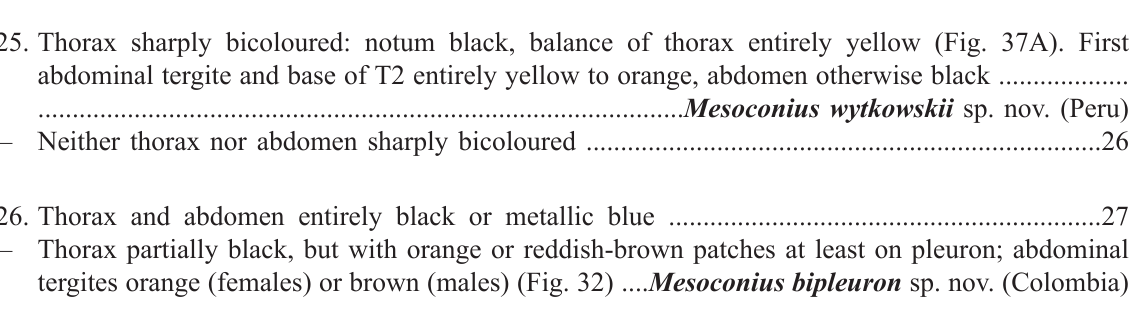
25. Thorax sharply bicoloured: notum black, balance of thorax entirely yellow (Fig. 37A). First abdominal tergite and base of T2 entirely yellow to orange, abdomen otherwise black